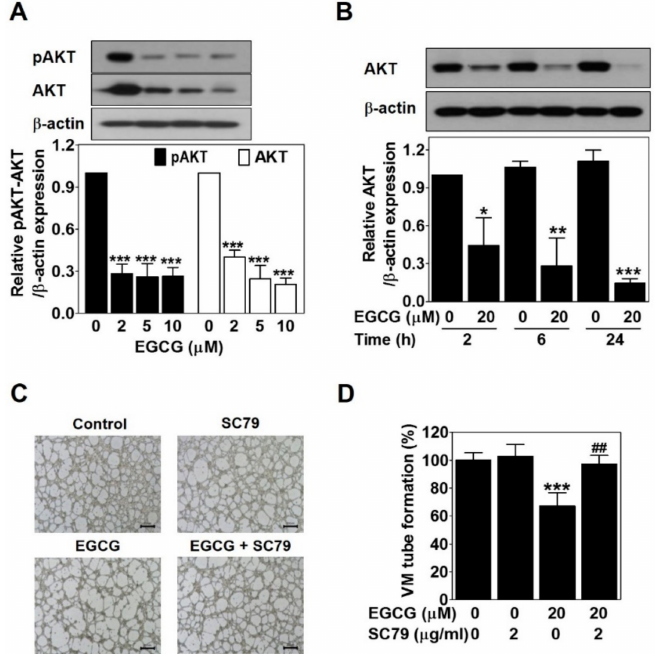
Figure 5. EGCG suppresses the VM of PC-3 cells through inhibiting the AKT pathway. Cells were treated with various concentrations of EGCG (10, 20, and 40 µ M) for 24 h ( A ) and with 20 µ M EGCG for 2, 6, and 24 h ( B ). Total protein lysates (20 µ g) analyzed by Western blot using specific antibodies. β -actin was used as a loading control. Data are expressed as means ± SD. Results were statistically calculated by Student’s t -test. * p < 0.05, ** p < 0.01, and *** p < 0.001 vs. untreated control. ( C ) Cells were pretreated with 2 µ g / mL SC79 for 1 h and then treated with 20 µ M EGCG for 24 h. VM structures were photographed at 40 × magnification. Scale bar = 250 µ m. ( D ) The number of VM structures was quantified. Data are expressed as means ± SD. Results were statistically calculated by Student’s t -test. *** p < 0.001 vs. untreated control; ## p < 0.01 vs. only EGCG-treated